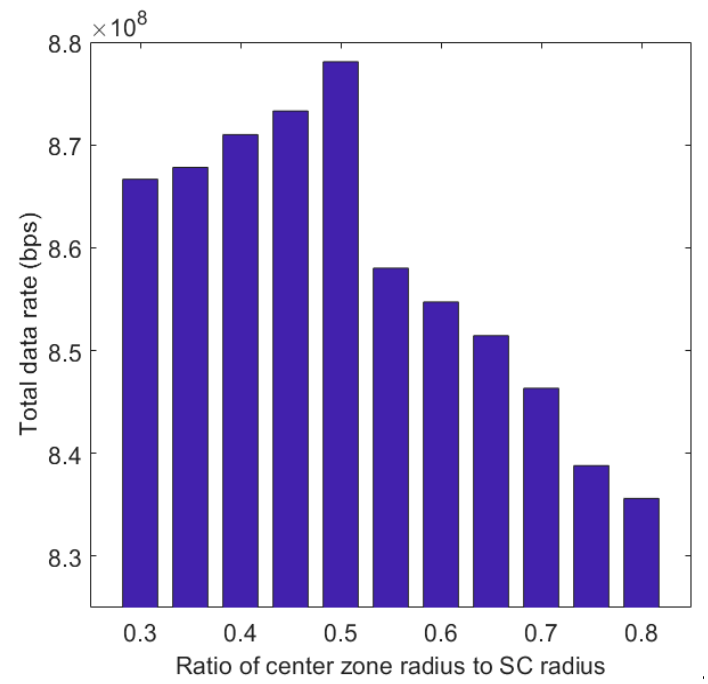
Figure 10. Total system data rate for different fractions of a center zone radius.